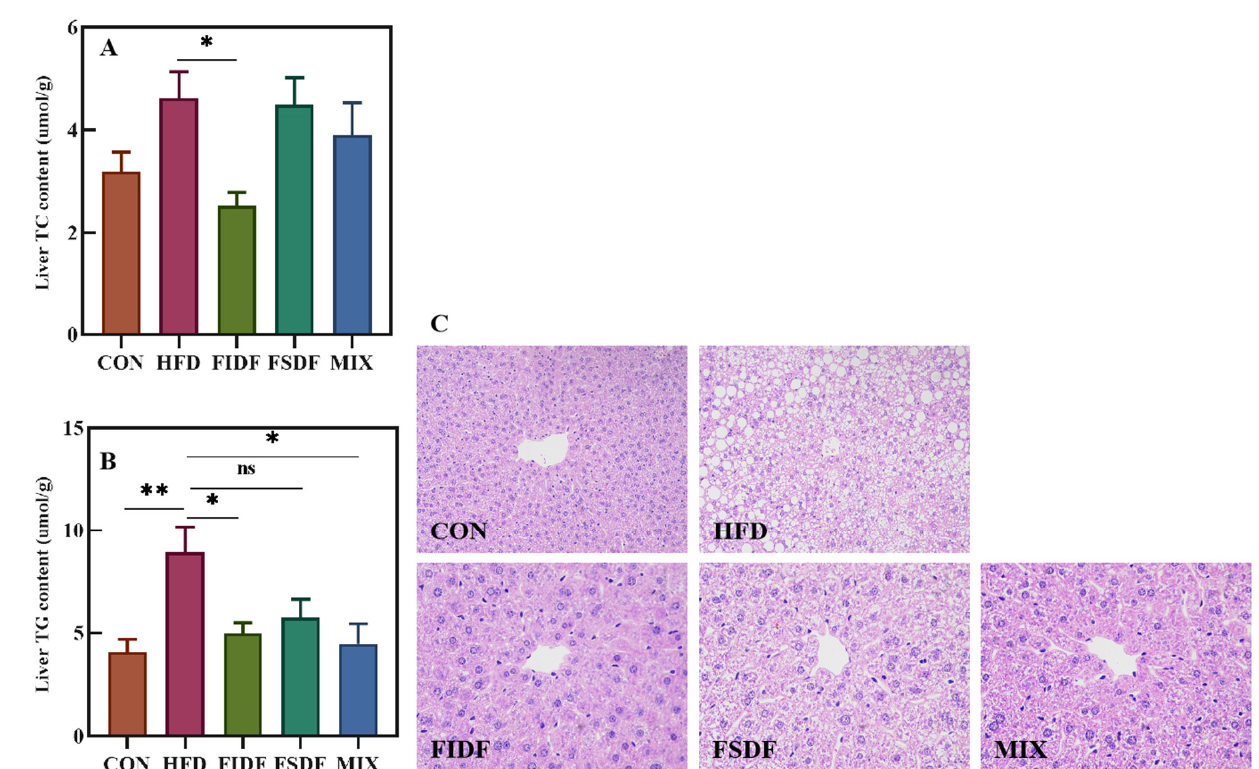
Figure 3. Effects of FIDF and FSDF on hepatic lipid accumulation and hepatic histomorphology. ( A ) Liver TC content. ( B ) Liver TG content. ( C ) HE staining of liver sections in different groups (shown at 400 × magnification). CON, control group; HFD, high-fat diet group; FIDF, group supplemented with FIDF alone; FSDF, group supplemented with FSDF alone; MIX, group supplemented with FIDF and FSDF together. Data are expressed as mean ± SEM ( n = 6). * p < 0.05; ** p < 0.01; ns, not significant.